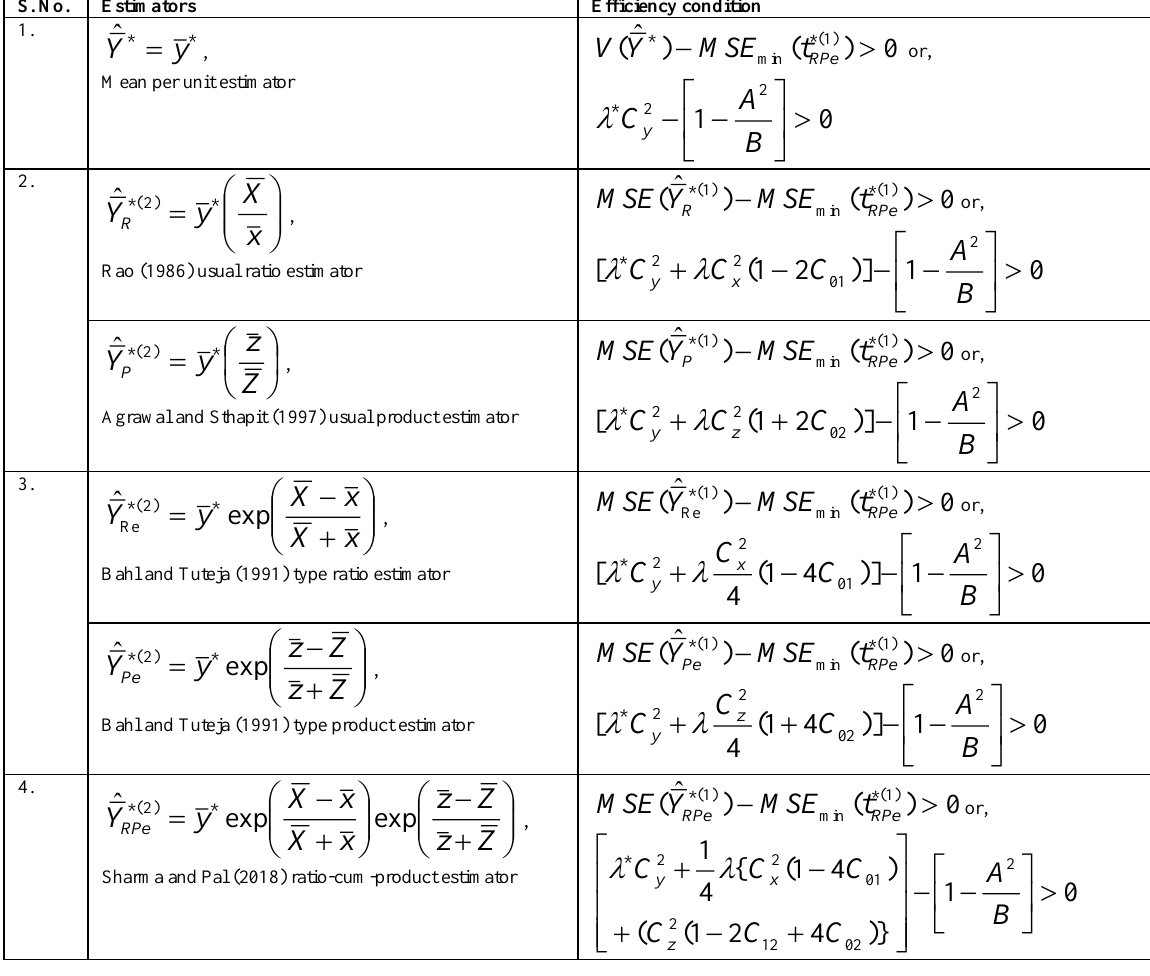
Table 4. Comparison with competing estimators under second strategy of non-response S. No. Estimators Efficiency condition